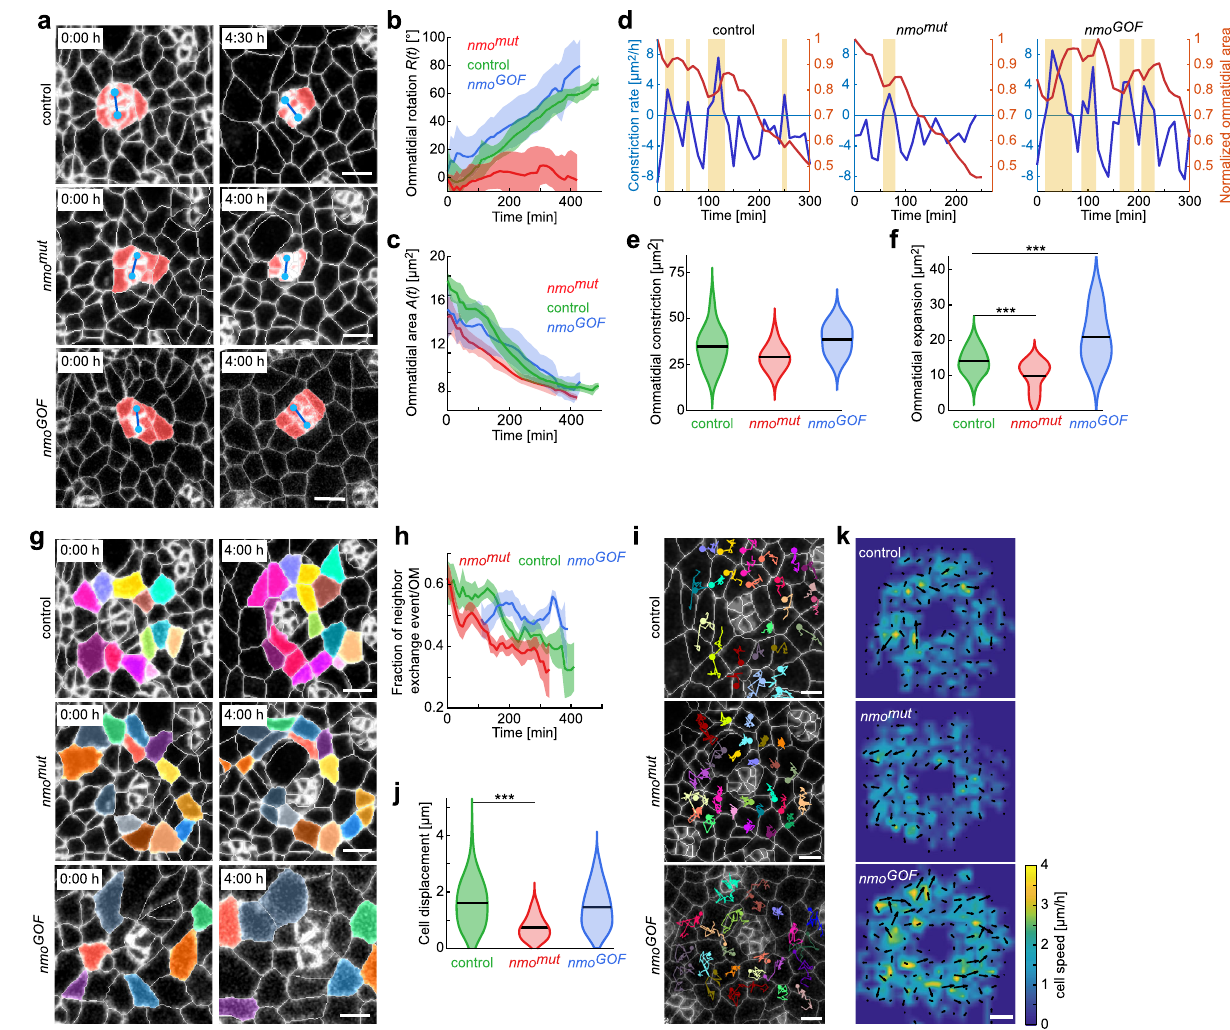
Fig. 3 Nmo kinase affects ommatidial rotation and interommatidial cell motility. a Snapshots of control, nmo mut (loss-of-function), and nmo GOF (gain-of- function) clusters during ommatidial rotation, respectively. The eight R-cells are highlighted in red, the R2/R5 pair is identi fi ed by blue centroid dots. b Ommatidial rotation as a function of time in nmo mut (red) and nmo GOF (blue), compared to the wt control (green). Line shows mean, and shaded region indicates standard deviation (in this panel and other equivalent panels). c Apical area of ommatidial clusters as a function of time for the three genotypes, as indicated. d Comparison of area constriction as a function of time for representative ommatidial clusters for the three genotypes. Note that all three constrict their apical area (orange line and scale on the right), but the constriction dynamics, measured by constriction rate (blue line and scale on the left), vary between the genotypes. In wt control, constriction happens in pulses followed by expansion (indicated by orange shaded boxes). In nmo mut , the expansion periods were fewer as compared to control, while in nmo GOF , expansion periods were longer and more frequent relative to control. e Violin plot of cluster constriction for control, nmo mut , and nmo GOF as indicated, measured as the total area during constriction periods. f Violin plot of cluster expansion for control, nmo mut , and nmo GOF genotypes measured as the total area during expansion periods. (*** p = 0.005 and 0.004, respectively). g Snapshots of randomly selected ICs colored to illustrate neighbor exchange in control, nmo mut , and nmo GOF , respectively. h Fraction of ICs that were the fi rst-level neighbors of the photoreceptor clusters and underwent neighbor exchange in between frames plotted as a function of time. i Snapshots with IC centroid trajectories for the three genotypes, each differently colored, in a 3 h window. j Violin plot of average cell displacement for ICs (*** p = 5.76 × 10 − 32 ). k Average cell speed and displacement of ICs during ommatidial rotation in control, nmo mut , and nmo GOF , respectively. For each genotype, the trajectories of ICs from all ommatidia were pooled, and average displacement (black arrows) and cell speed (heat map) were measured. All scale bars: 3 µ m. Measurements in b , c , e , f , h , j , and k are averaged over 17 nmo mut ommatidia from two pupae and 18 nmo GOF ommatidia from two pupae from movies >300 min. To calculate the p -values in ( f and j ), two-tailed Student ’ s t-test was